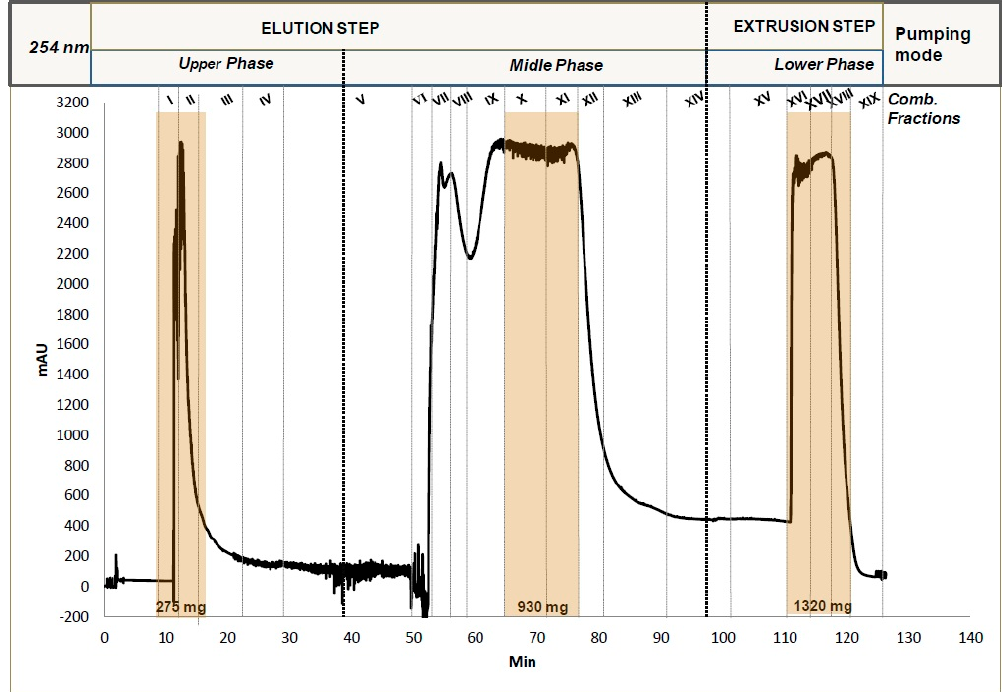
Figure 1. Step-gradient CPC chromatogram of 3 g crude methanol extract of P. abies bark at 254 nm; Stationary phase: lower phase of the triphasic system; Mobile phase; upper and middle phases for the elution step and lower phase for the extrusion step, all in ascending mode.